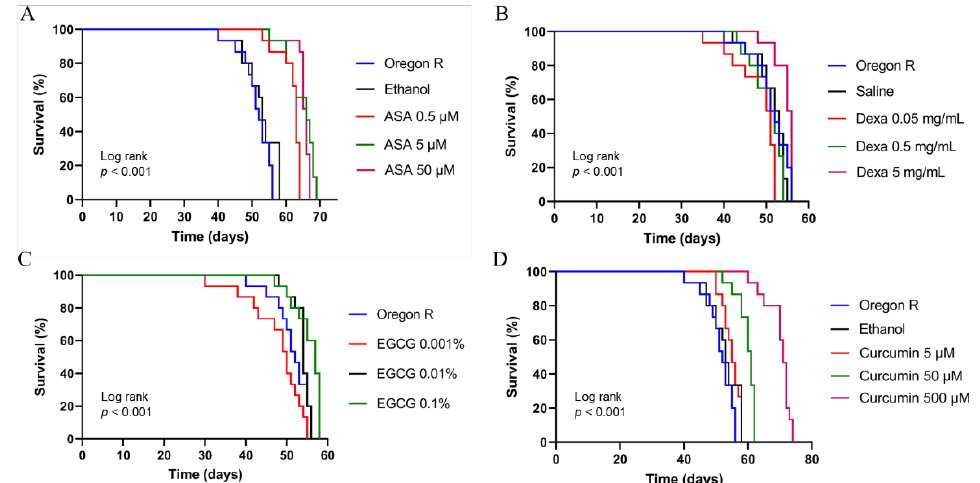
Figure 2. The lifespan of adult males of Oregon R in the presence or absence of aspirin ( A ), dexamethasone ( B ), EGCG ( C ), and curcumin ( D ). For each survival experiment, adult males of Oregon R aged 4–7 days old were maintained at 25 ◦ C in fly food containing the respective drug/active compounds. The numbers of surviving and dead flies were recorded daily, and fly survivorship was analyzed using a Kaplan – Meier Log Rank approach. ASA, Aspirin; Dexa, Dexamethasone; EGCG; epigallocatechin gallate.